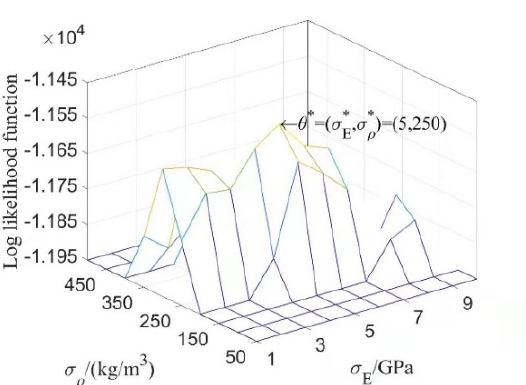
ρ are random fields.